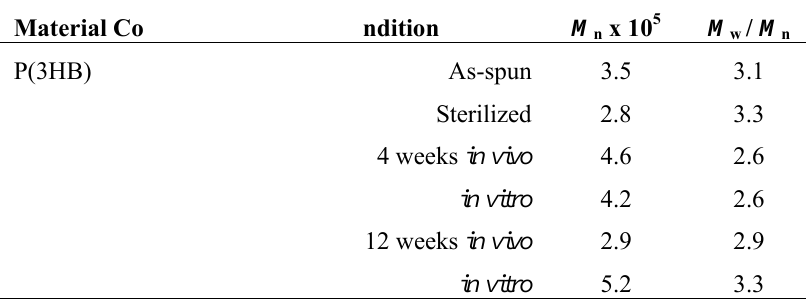
Table 2 . Molecular weight of PHA copolymers in the as-spun state, after sterilization, and after in vivo implantation and in vivo degradation